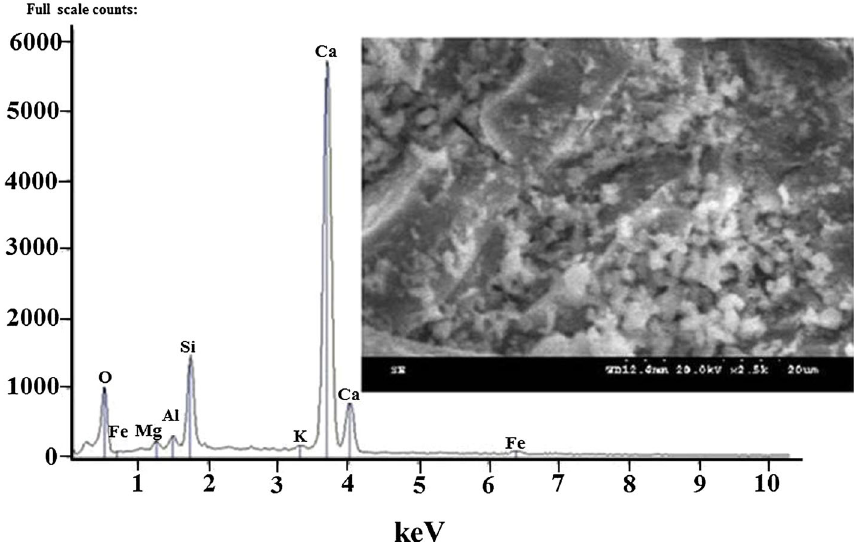
Fig. 9 SEM analysis for FRL20.